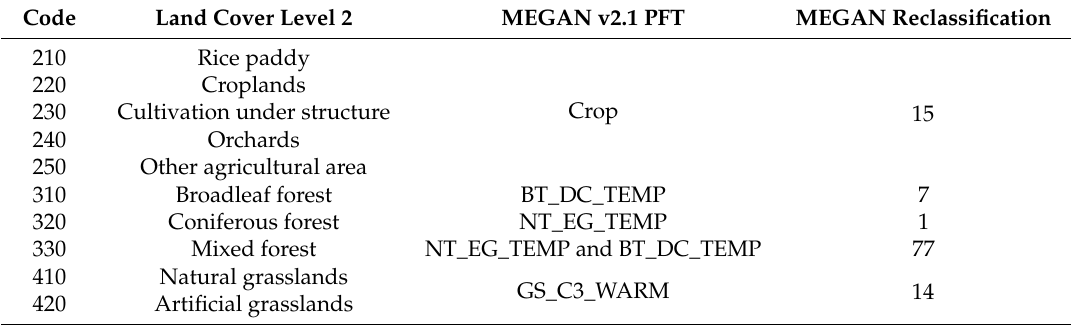
Table 3. Mapping Korea Landcover Level 2 into MEGAN v2.1 PFT (Vegetation only) [8]. Code